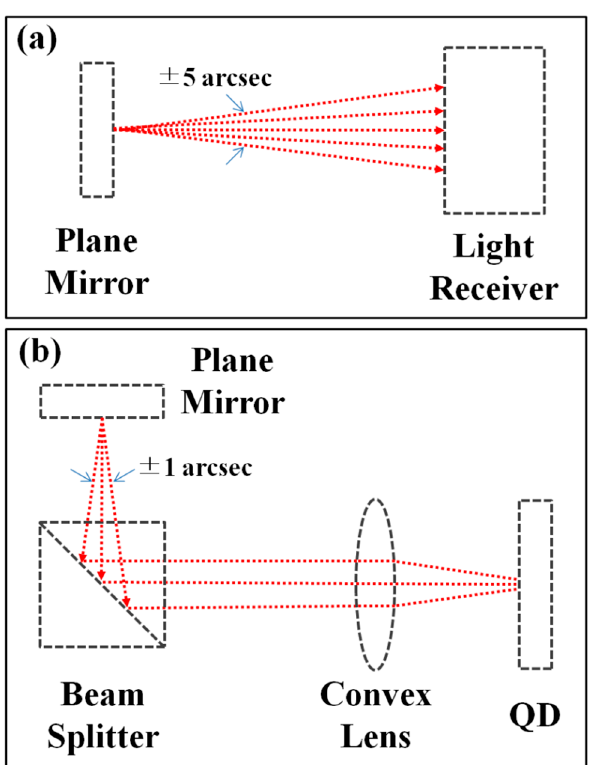
Figure 2. The optical path of altitude angle calibration. ( a ) The tolerance error of the commercial laser interferometer and ( b ) the proposed module based on the autocollimator principle could reduce the tolerance error of the commercial laser interferometer.